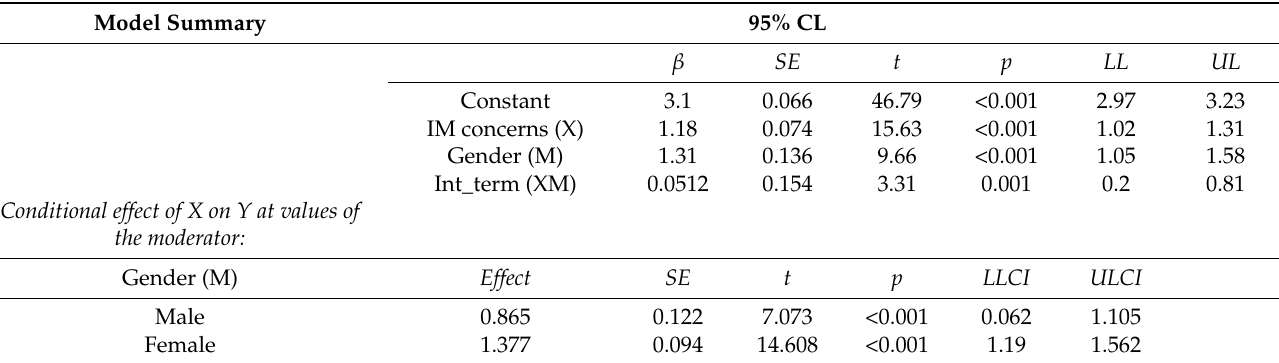
Table 2. Moderating role of gender (M) on the relationship between IM concerns (X) and social media fatigue (Y).